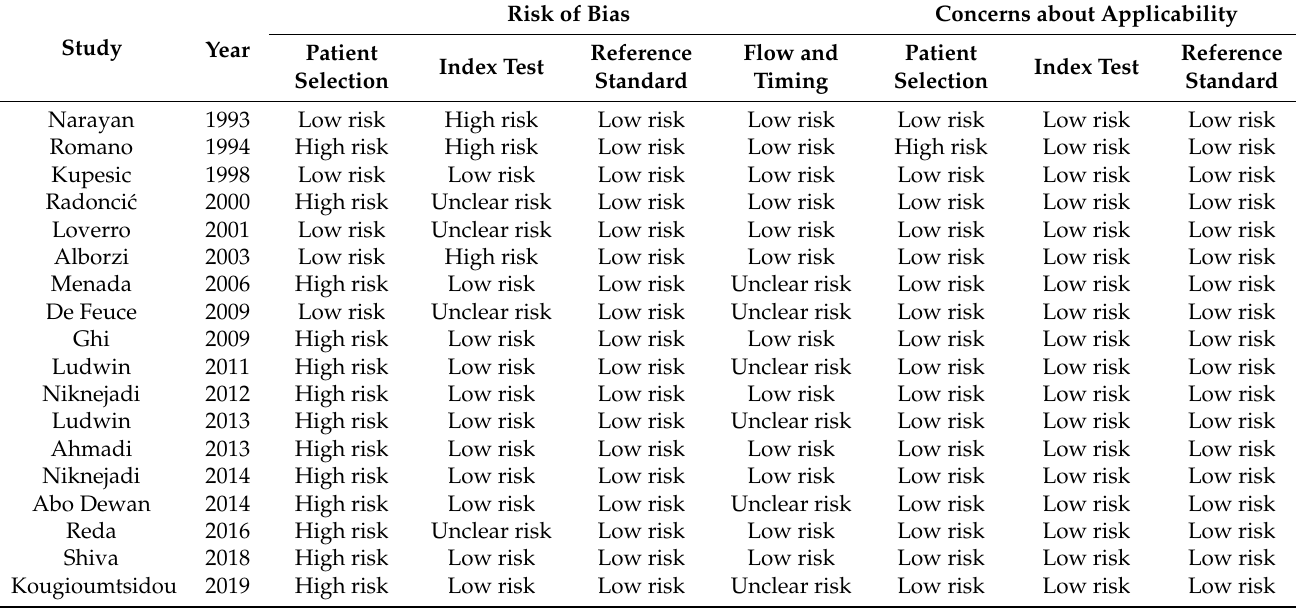
Table 2. Quality assessment (risk of bias and concerns of applicability) for all studies included in the